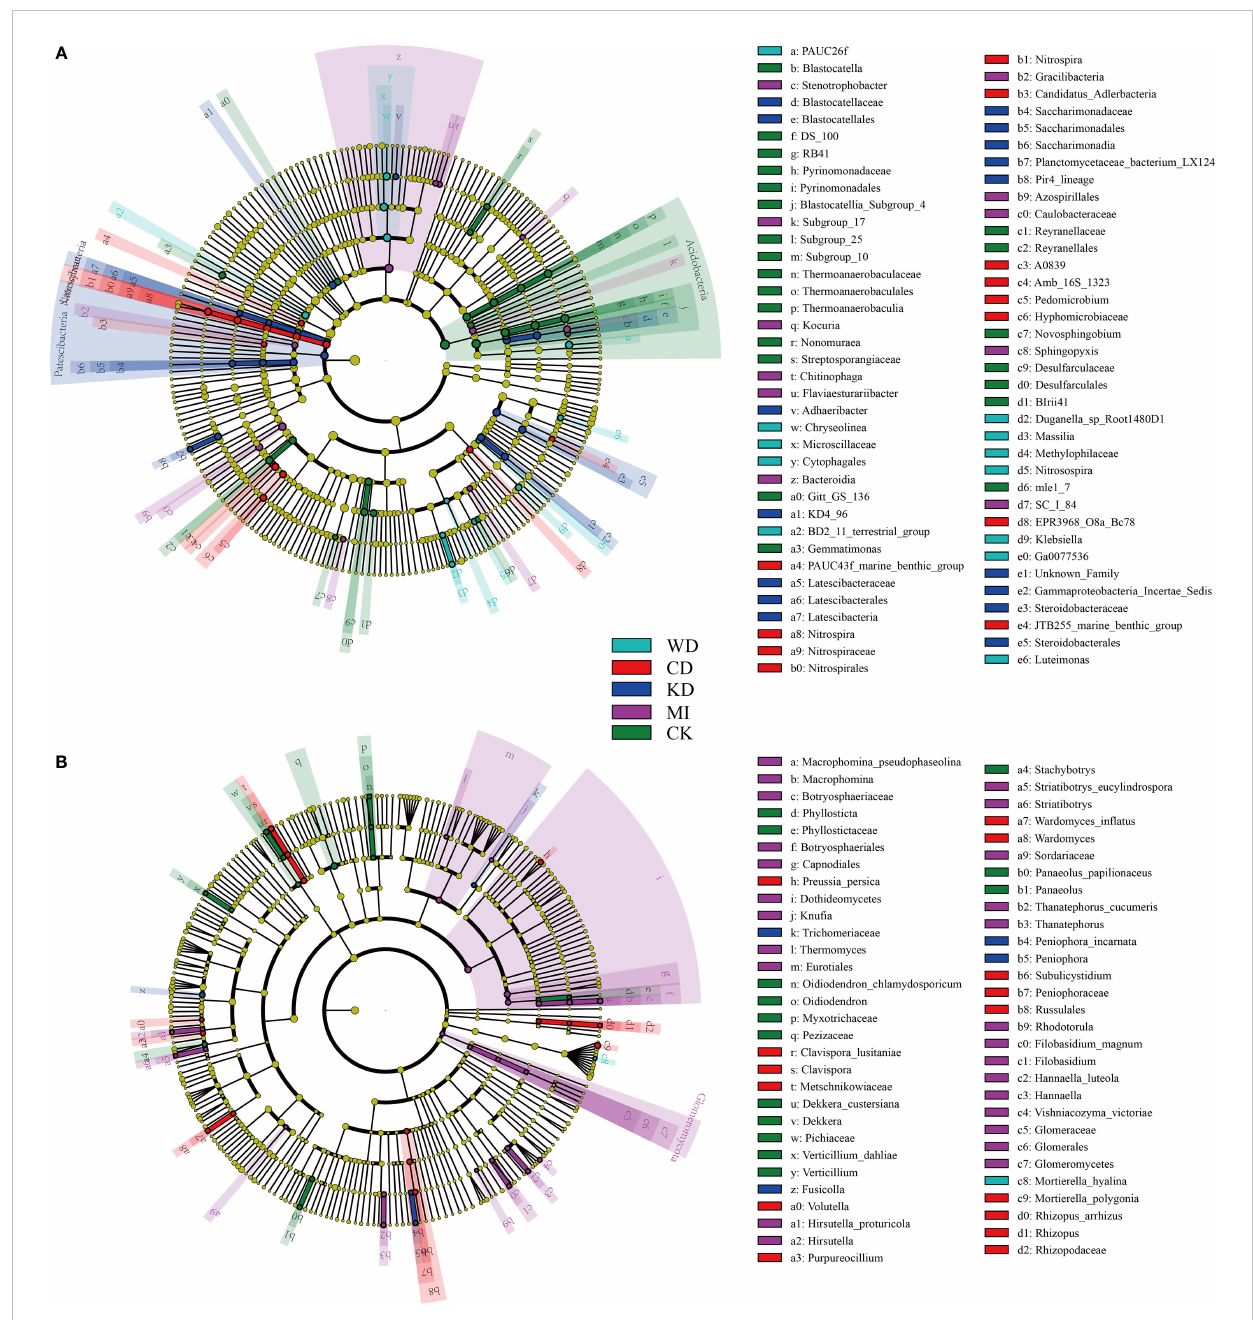
FIGURE 3 Linear discriminant analysis effect size (LEfSe) taxonomic cladogram identi fi ed signi fi cantly discriminant bacteria (A) and fungi (B) taxa (LDA > 2) associated with soils of different intercropping modes. WD, watermelon-daylily intercropping; CD, cabbage-daylily intercropping; KD, kale-daylily intercropping; MI, row mixed intercropping, watermelon, cabbage, and kale were alternately intercropped with daylily; CK, monoculture